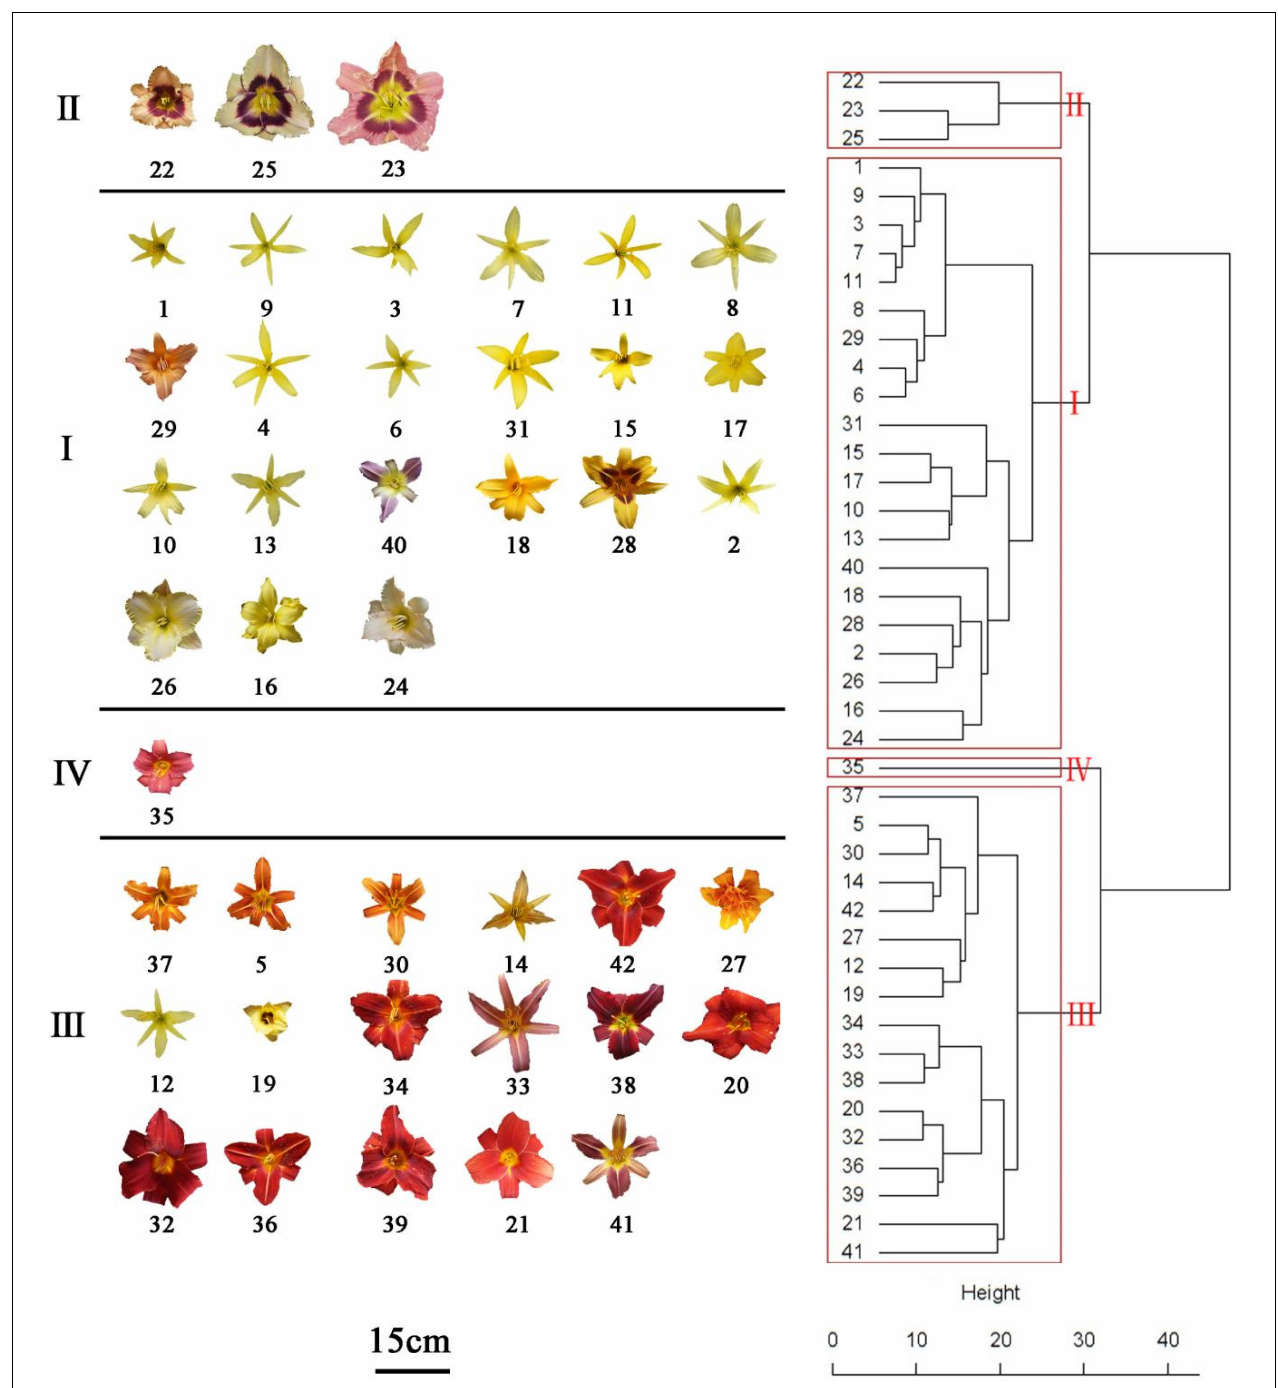
FIGURE 5 | Hierarachical cluster dendritic diagram of 42 Hemerocallis accessions.